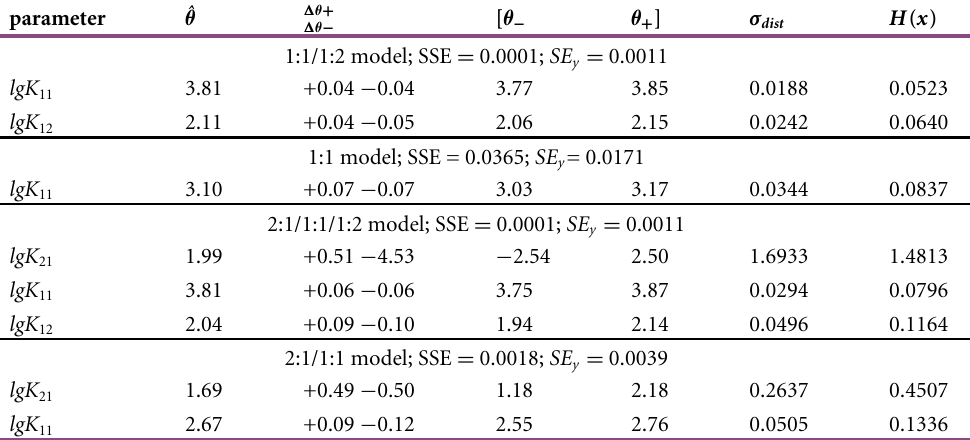
Table 1 Stability constants of the four tested models, the 95% confidence intervals obtained from Monte Carlo simulations including the median, σ dist and H ( x ) calculated from the distribution of the parameters, partitioned into 30